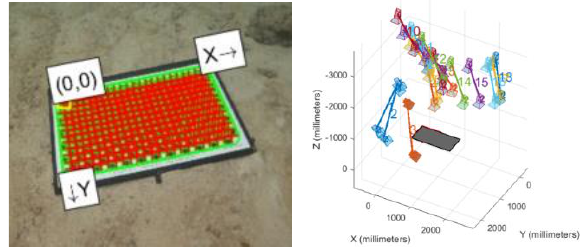
Figure 6. On the left, the checkerboard pattern detected by the Stereo Camera Calibrator of Matlab; on the right, pattern- centric view of the estimated positions of the SA2-SA3 stereo couples.